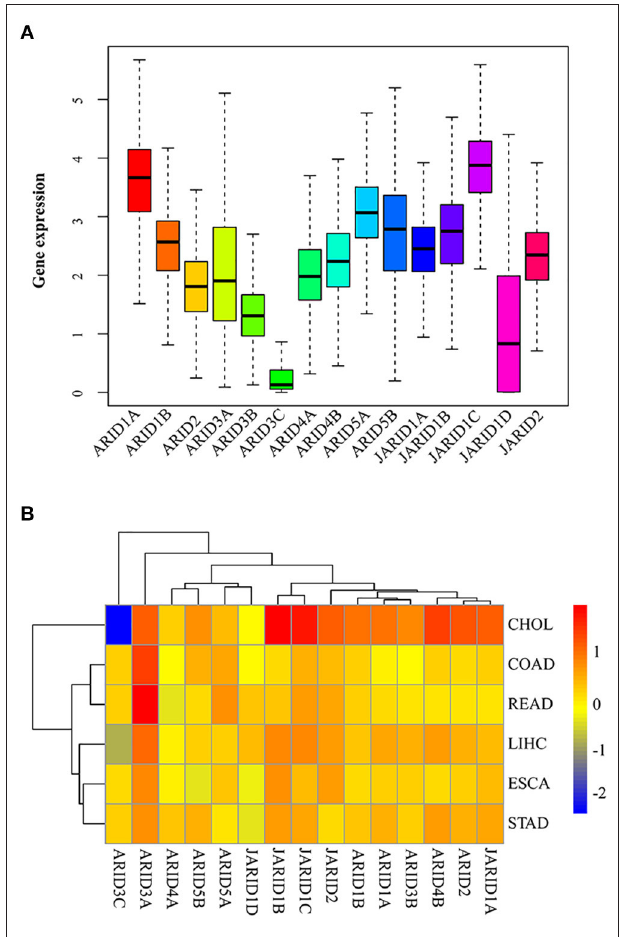
FIGURE 1 | Expression levels of ARID gene family in digestive cancer. (A) Total expression of ARID family members across seven digestive cancer types. (B) Difference of ARID gene expression comparing tumour to normal tissues based on fold change of log2 transformation for six cancer types.